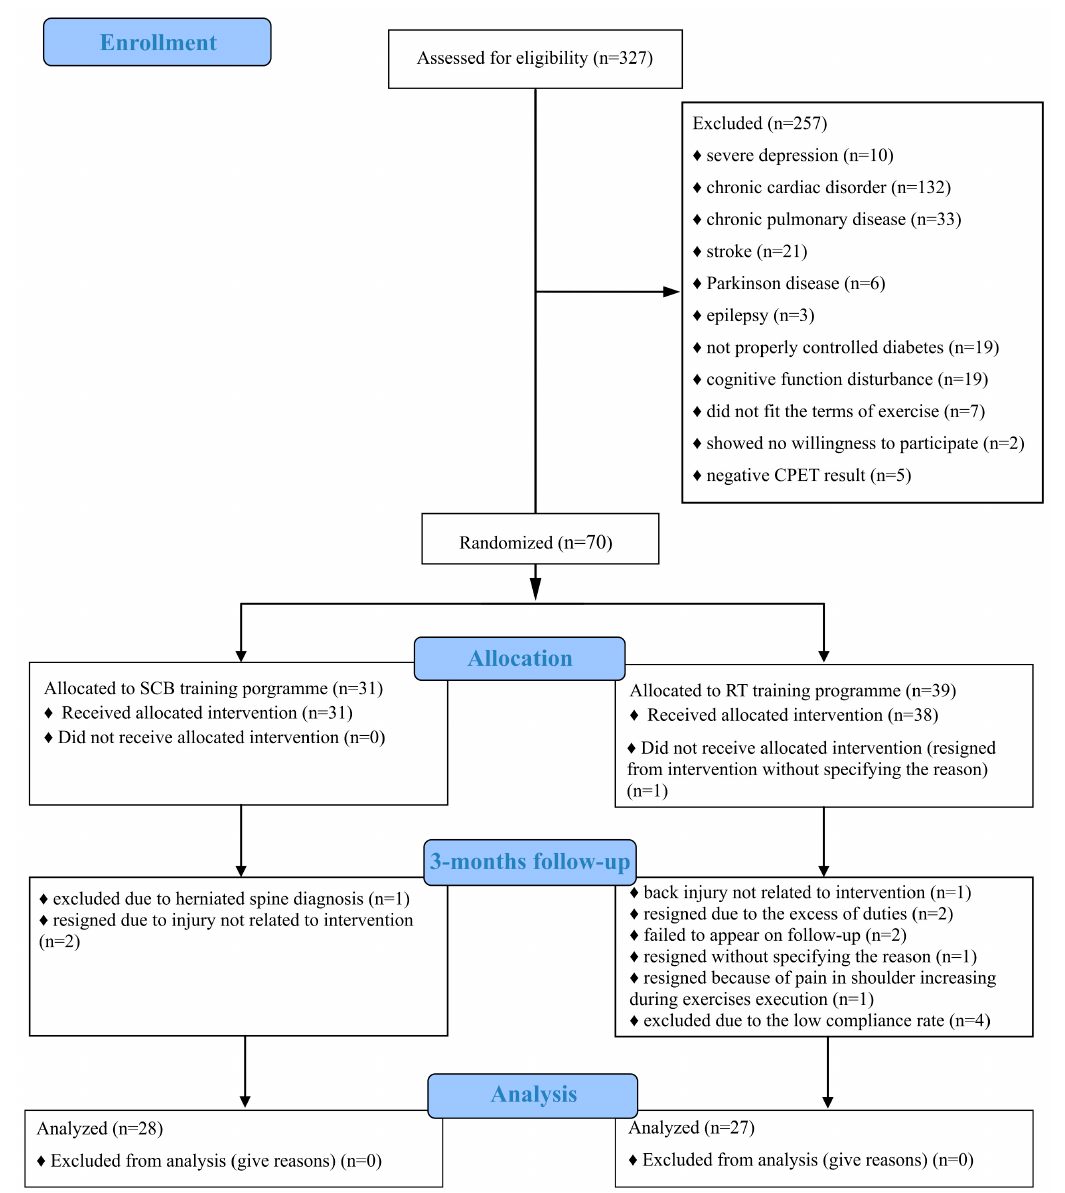
Figure 1. Study flow-chart